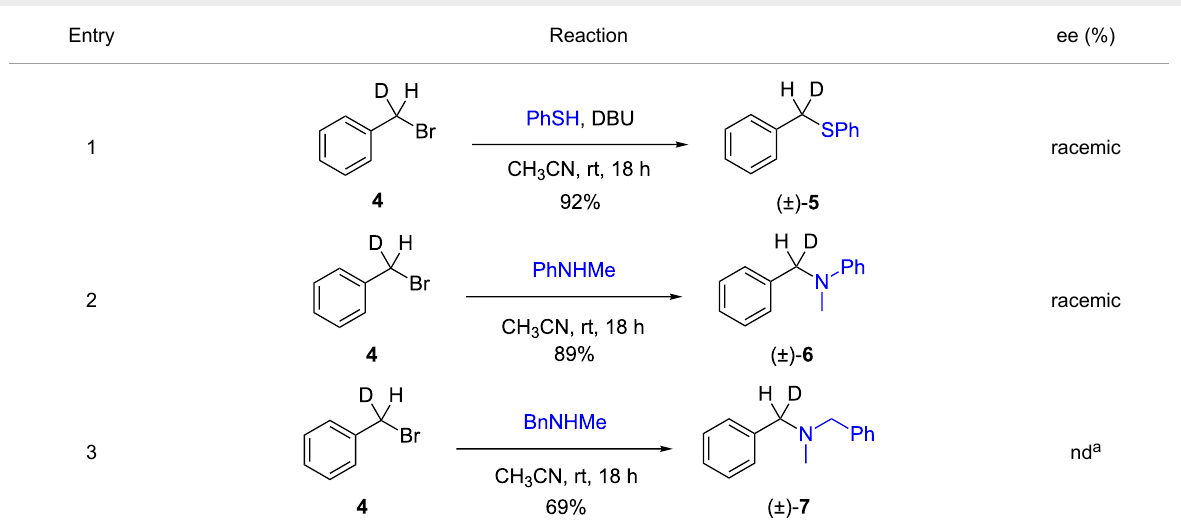
Table 1: Nucleophilic substitution reactions of racemic 7-[ 2 H 1 ]-benzyl bromide ( 4 ).